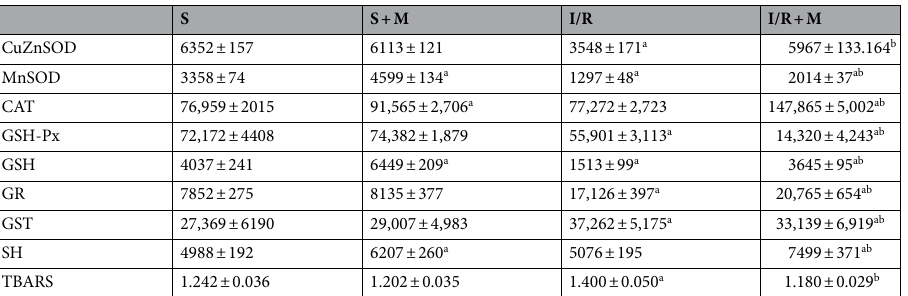
Table 3. The activities of liver copper-zinc superoxide dismutase (CuZnSOD, U/g tissue), manganese superoxide dismutase (MnSOD, U/g tissue), catalase (CAT, μmol H 2 O 2 /min/g tissue), glutathione peroxidase (GSH-Px, μmol NADPH/min/g tissue), glutathione reductase (GR, nmol NADPH/min/g tissue) and glutathione S-transferase (GST, nmol GSH/min/g tissue), as well as liver concentrations of glutathione (GSH, nmol/g tissue), sulfhydryl groups (SH, nmol/g tissue), and lipid peroxides (TBARS, nmol/g tissue). Experimental group abbreviations: S sham-operated rat group, S + M sham-operated + meldonium rat group, I/R ischemia/reperfusion rat group, I/R + M ischemia/reperfusion + meldonium rat group. The number of animals per experimental group: n = 8. The data are given as mean ± standard error of the mean. Minimal significant level: p < 0.05. Significantly different: a in respect to S group; b in respect to I/R